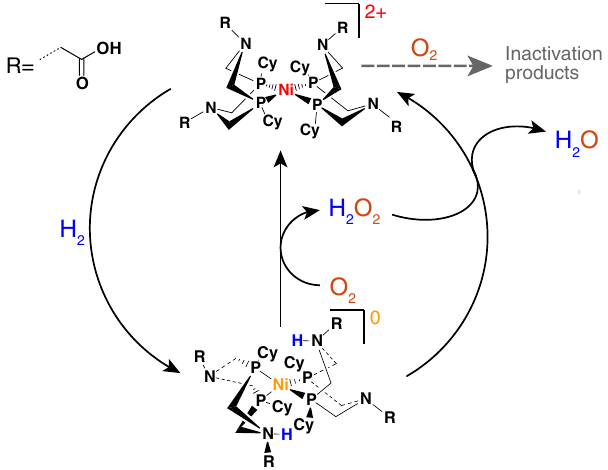
Fig. 1 Reactions of the CyGly complex with H 2 /O 2 in solution. The Ni 2 + complex, [Ni II (P Cy 2 N Gly 2 ) 2 ] 2 + , undergoes slow and irreversible inactivation by O 2 while the H 2 reduced Ni 0 complex, [Ni 0 (P Cy 2 N Gly 2 ) 2 ], is able to catalytically reduce O 2 to H 2